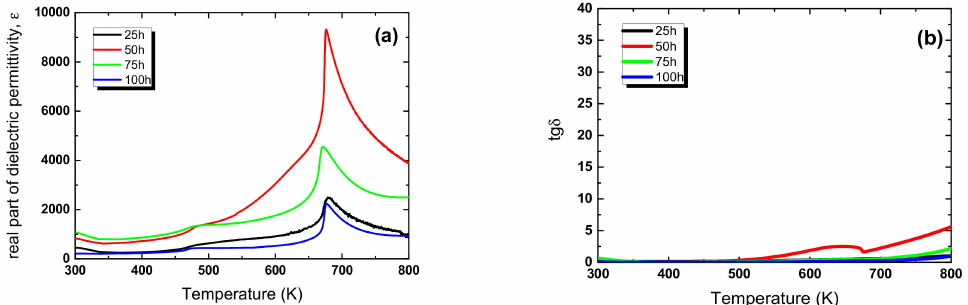
Figure 6. Temperature dependencies of dielectric permittivity ( a ) and loss tangent ( b ) measured during heating at frequency 10 kH for KNN ceramics obtained from 25 h, 50 h, 75 h, and 100 h milled